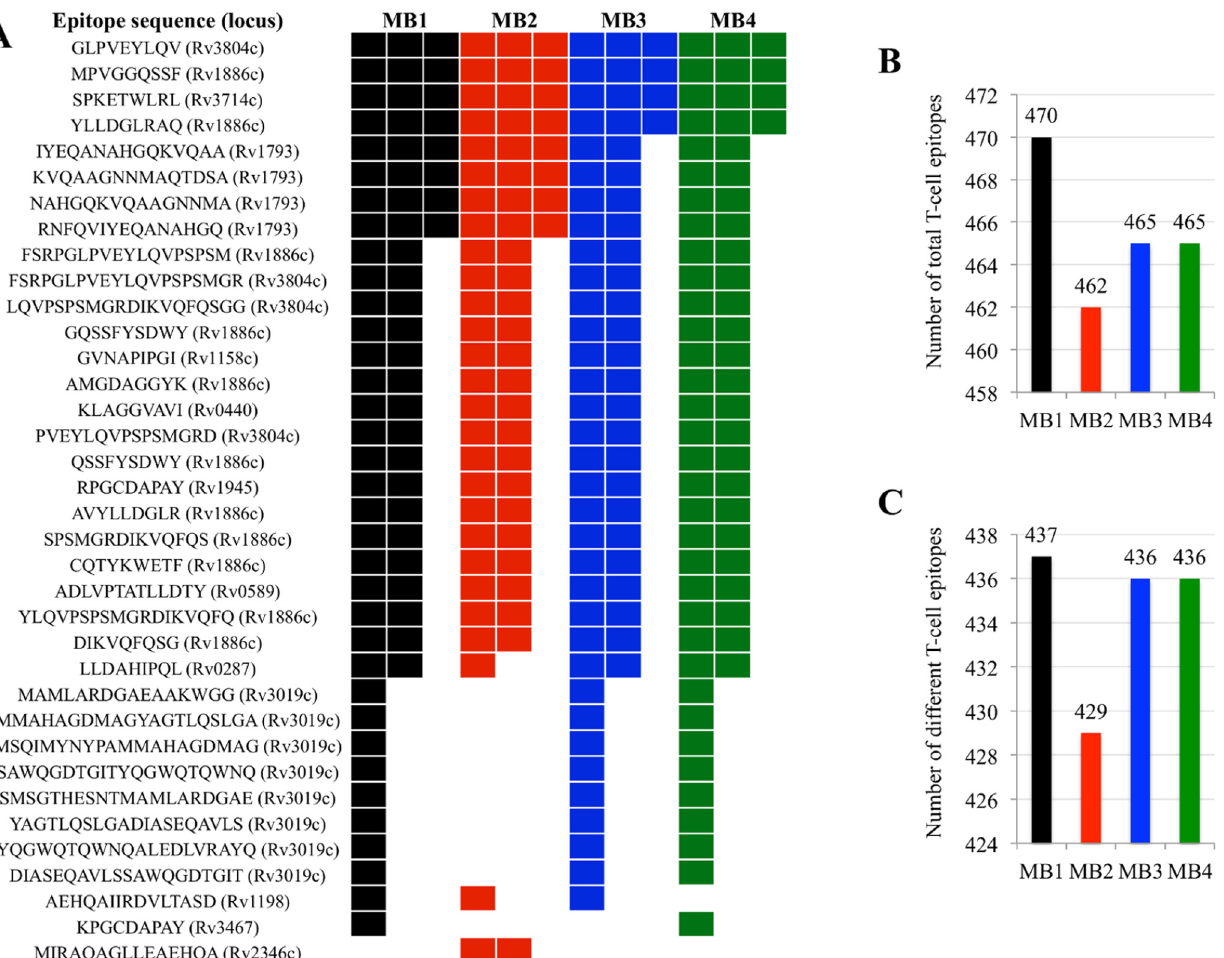
Fig 6. Host T cell epitopes of mycobacteria. (A) Organization of the repeated/deleted epitopes in the different sequenced mycobacteria isolates. The locus name of the antigen in the H37Rv genome for T-cell epitope containing antigens [17] is shown in parenthesis after epitope sequence. The protein annotation according to the Immune Epitope Database (IEDB; http://www.iedb.org) can be found in S4 Table. Each column represents epitope repeat or deletion. (B) Total number of T cell epitopes including repetitions identified on each mycobacteria. (C) Number of different T cell epitopes identified on each mycobacteria.